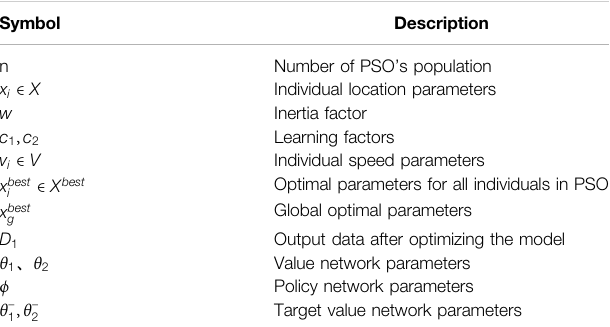
TABLE 2 | Symbol description table of